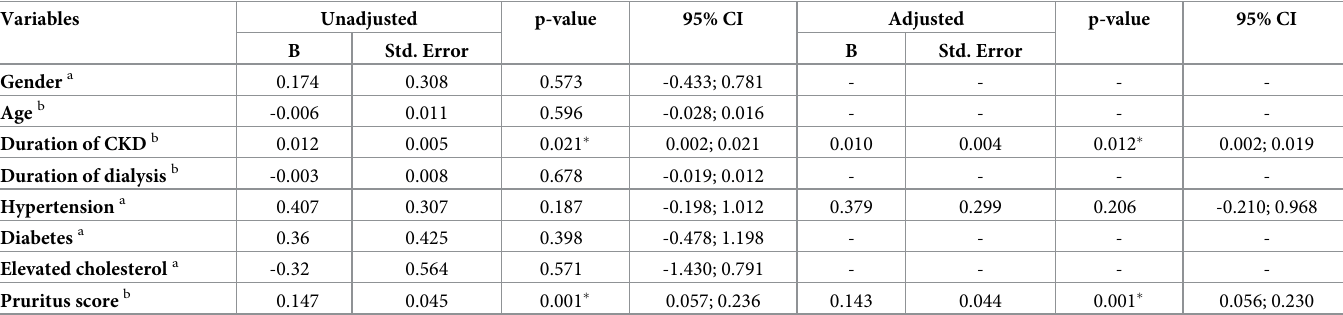
Table 6. Association between PSQI score with gender, duration of CKD, duration of receiving dialysis, and severity of pruritus (n = 262). Variables Gender a